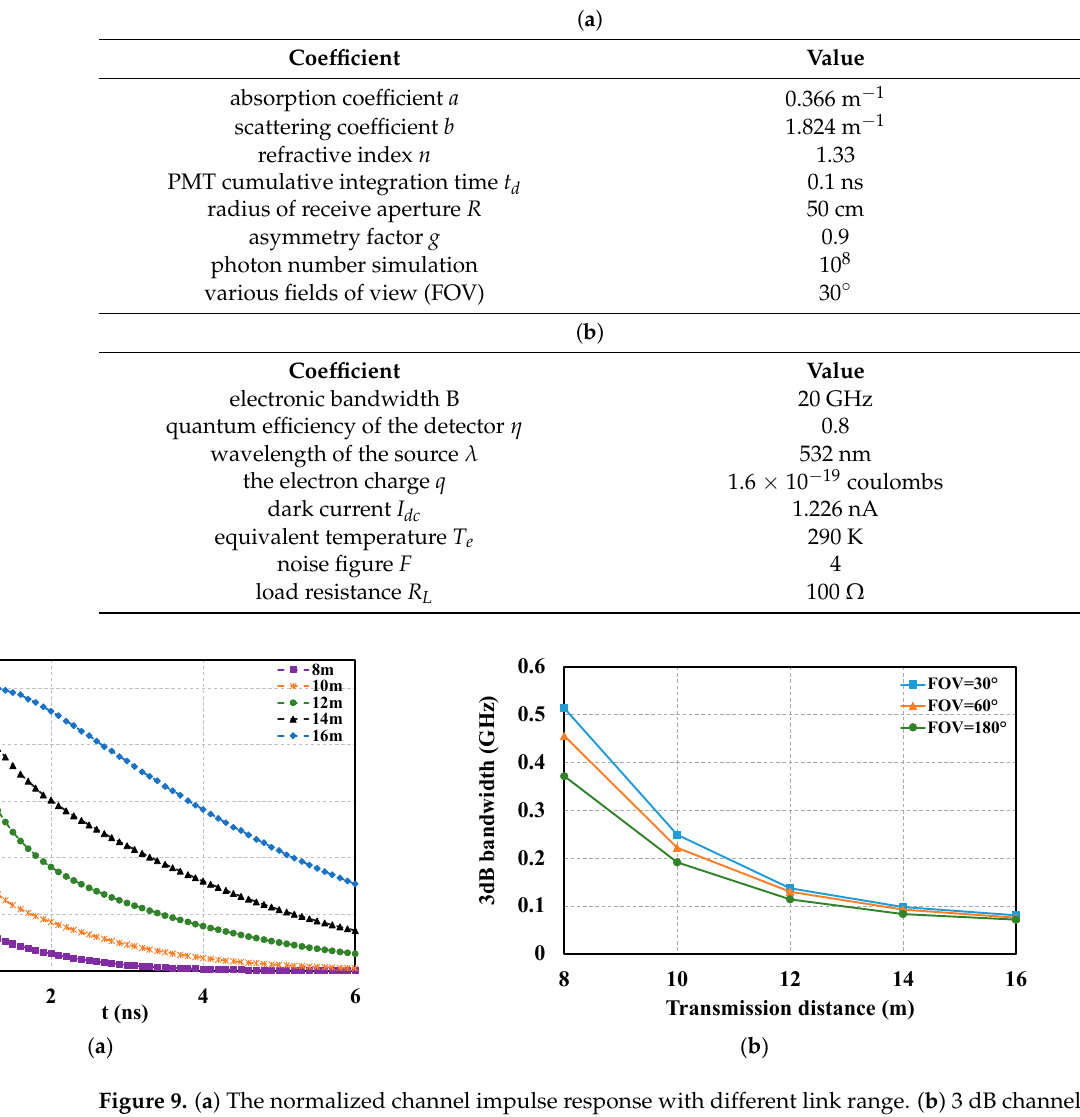
Figure 10. BER vs. MLSE tap number by transmitting 0.4, 0.6, 0.8, and 1 Gb/s Signal bitrate in harbor water of 10 m with transmit power of 24dBm and 30° FOV. As shown in Figure 10, the BER performance is considerably improved as the MLSE tap number increases. The BER of the 0.6 Gb/s OOK signal decreases from 4.5×10 − 3 to 1.34×10 − 5 for increasing MLSE tap number from 2 to 5. However, the system performance improvement is not obvious when the MLSE tap number increases from 5 to 7. Consider- ing that an increase in the tap number will improve the system complexity, we adopt a 5- taps MLSE as a trade-off between compensation effect and complexity. Due to the absorption and scattering of photons caused by particles in the water, the channel response shows temporal dispersion, i.e., temporal spread of the beam pulse, thus, leading to ISI. The OOK and pulse amplitude modulation (PAM) signals are inves- tigated, respectively, to evaluate the effect of ISI. We evaluate the system performance by